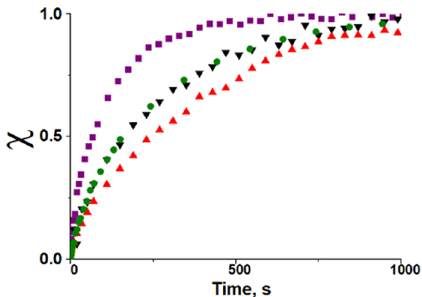
Figure 7. Dimensionless curves of methanol adsorption on ACM-35.4. Binder content: ■ —15, ▼ — 20, and ▲ —25 wt.%, ● —loose grains. Grain size 1.6–1.8 mm [107].